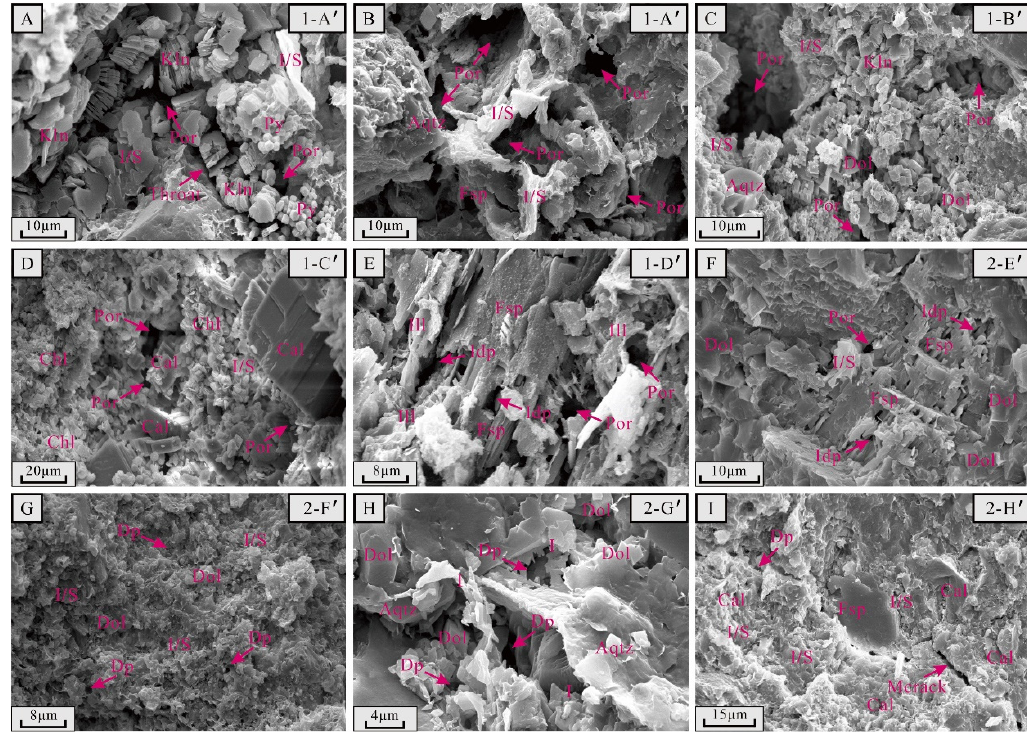
Figure 5. Scanning electron microscopy images of the selected samples. ( A - E ) Samples MSR; ( F - H ) Samples MCR.